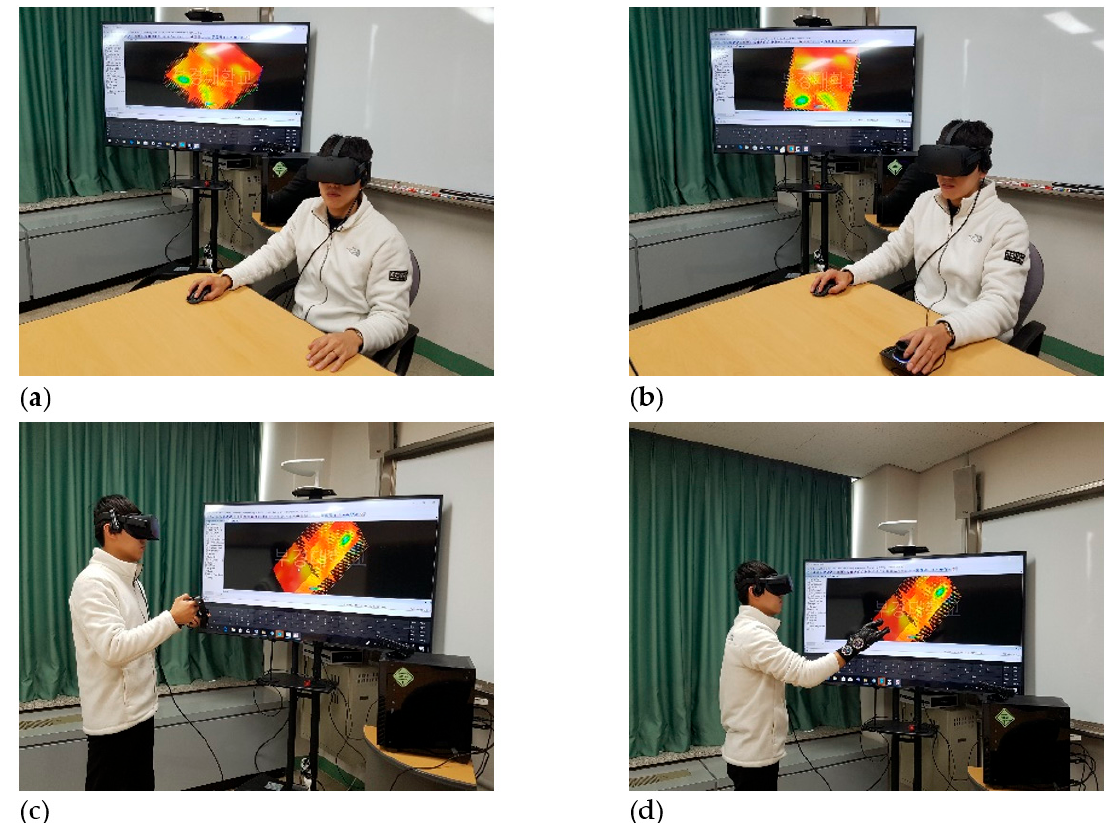
Figure 3. Images of experimenters controlling the KmodStudio software in a virtual reality (VR) environment using di ff erent user interface devices. ( a ) Two-dimensional (2D) mouse; ( b ) 2D and three-dimensional (3D) mice; ( c ) VR controller; and ( d ) bend-sensing data glove with a Kinect sensor.